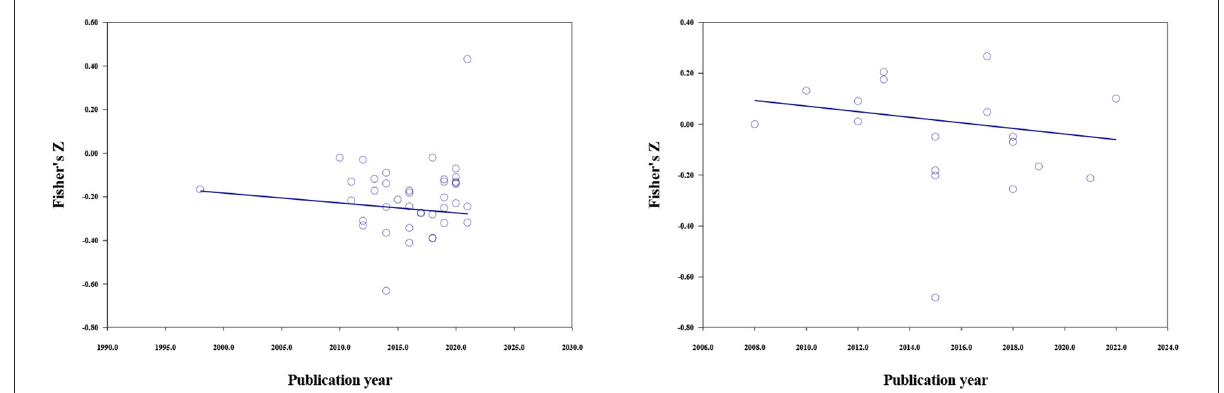
FIGURE5 The moderating effect of publication year; materialistic values (left), extrinsic aspirations (right).